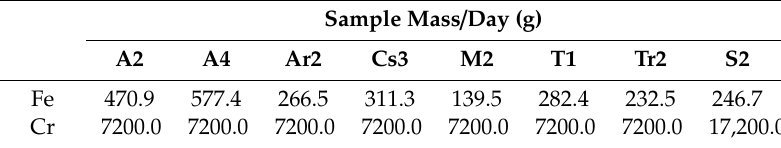
Table 8. Sample mass that can be consumed by day for iron and